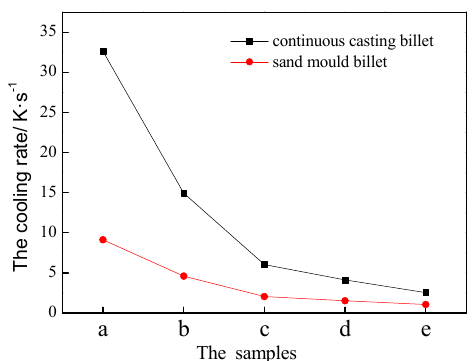
Figure 6. Calculated cooling rate of the different samples of M2 steel billets. Table 2. Ratios of λ 2 and calculated cooling rate for the different samples of billets cast with the continuous caster and sand mold.